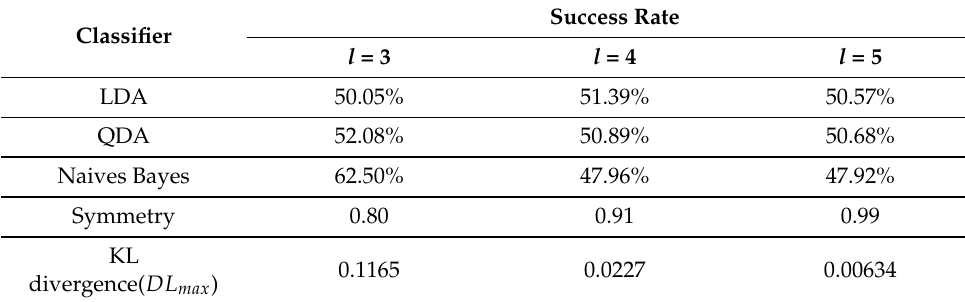
Figure 2. Distributions of residue shares. Table 2. Results of symmetry and ML classification for residue